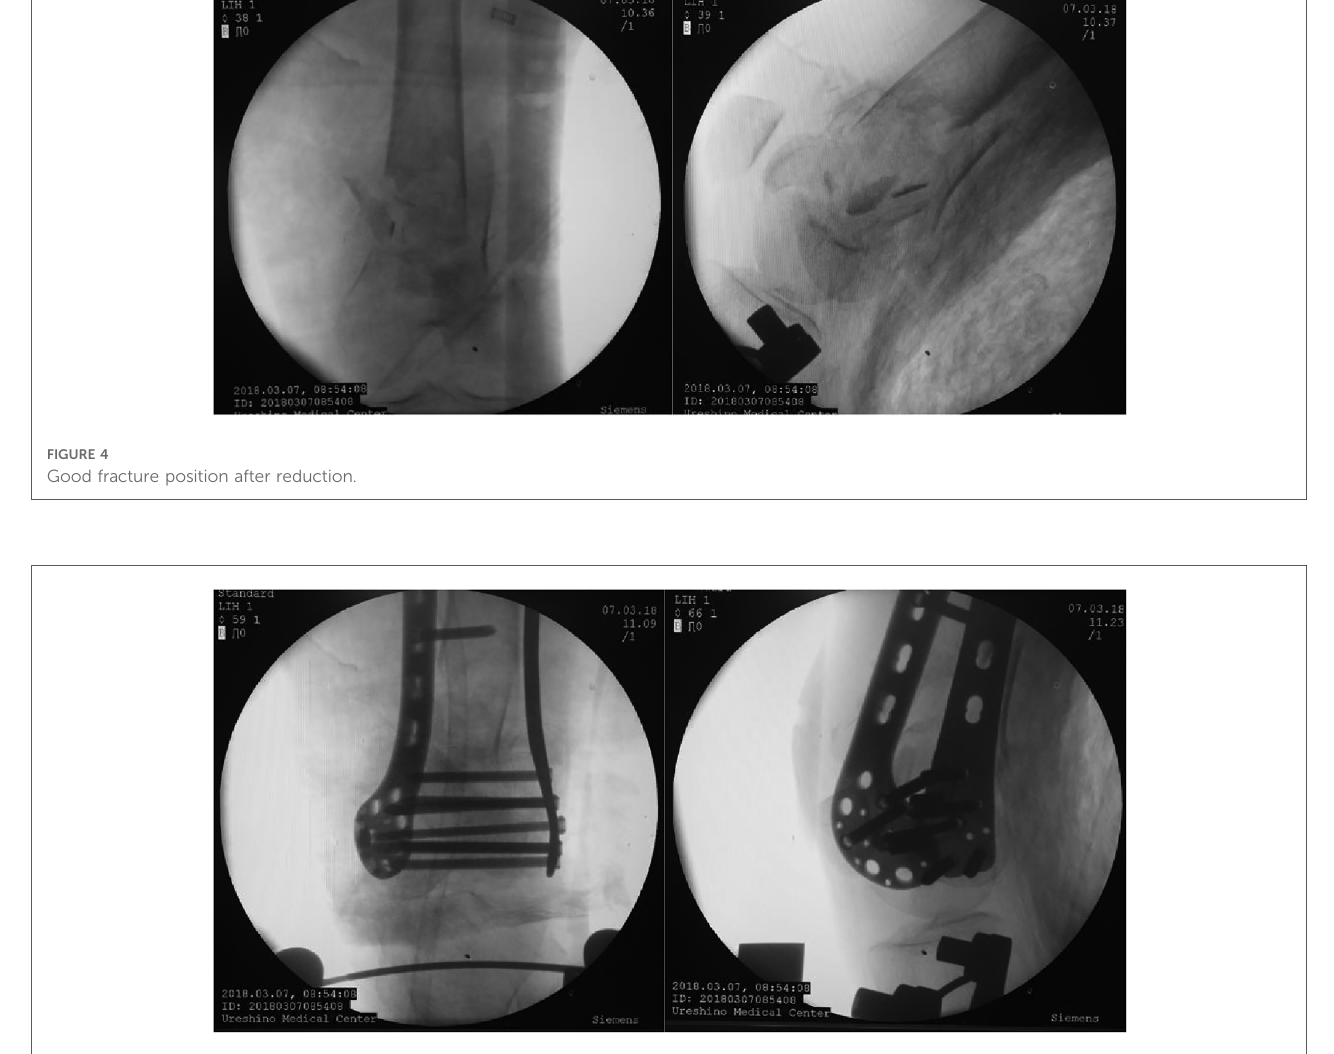
FIGURE 5 Perspective position after minimally invasive placement of the plate.